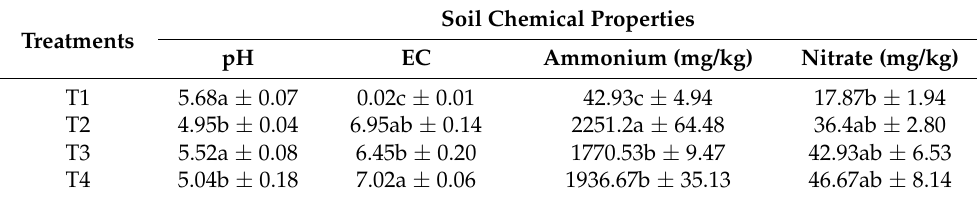
Table 6. Selected soil chemical characteristics at 10 days of an ammonia volatilization experiment.